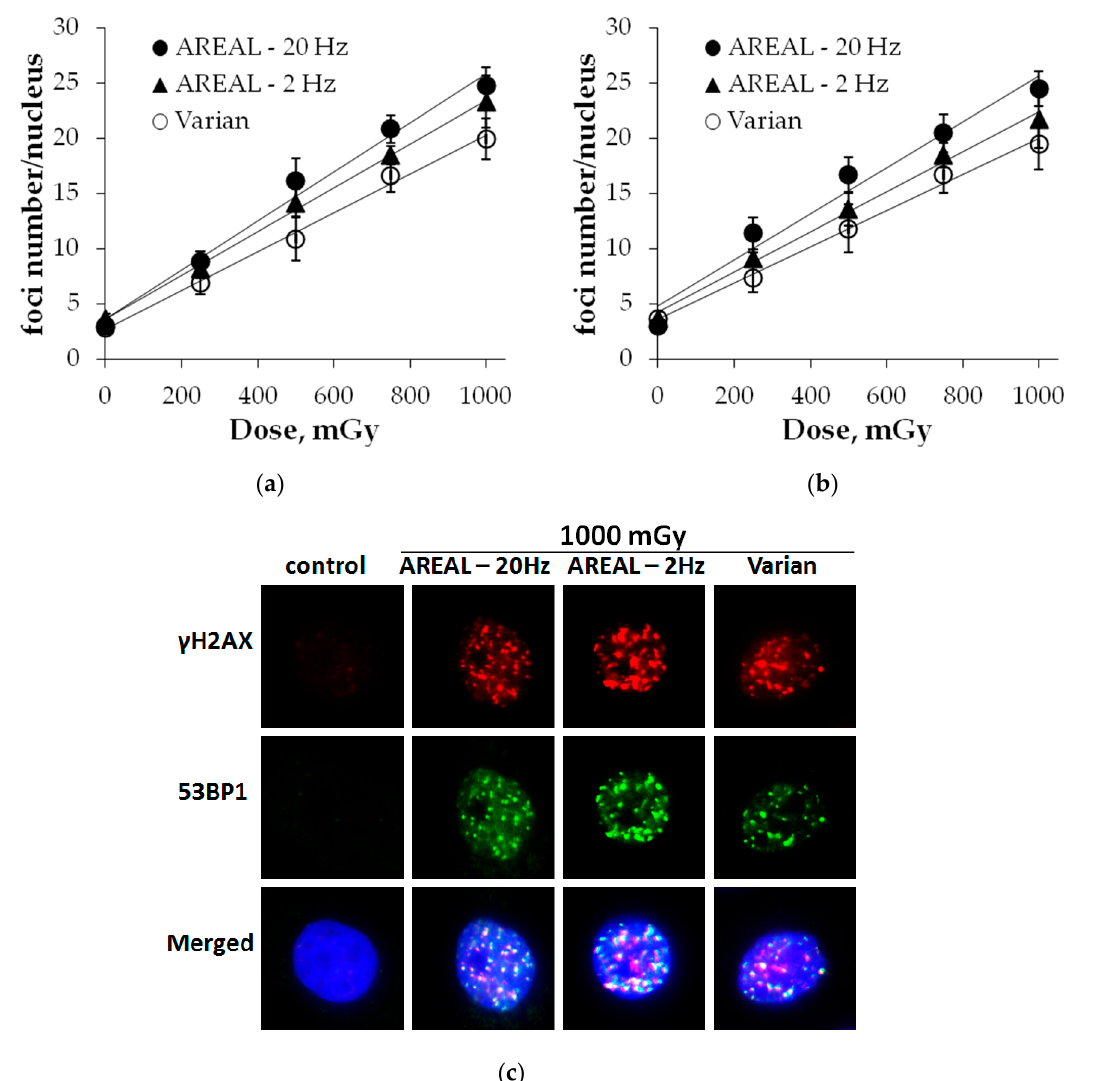
Figure 1. Dose-dependent changes in the γ H2AX ( a ) and 53BP1 ( b ) foci numbers in HeLa cells at 1 h post-irradiation by Advanced Research Electron Accelerator Laboratory (AREAL) (ultrashort pulsed 3.6 MeV electron beams) and Varian (quasi-continuous 4.0 MeV electron beams) accelerators; ( c ) representative images of γ H2AX and 53BP1 foci in cell nuclei. Nuclei were counter-stained with 4 ′ ,6-diamidino-2-phenylindole (DAPI), shown in blue. γ H2AX and 53BP1 foci are shown in red and green, respectively. Mean values derived from at least three independent experiments are shown. Error bars show SE.